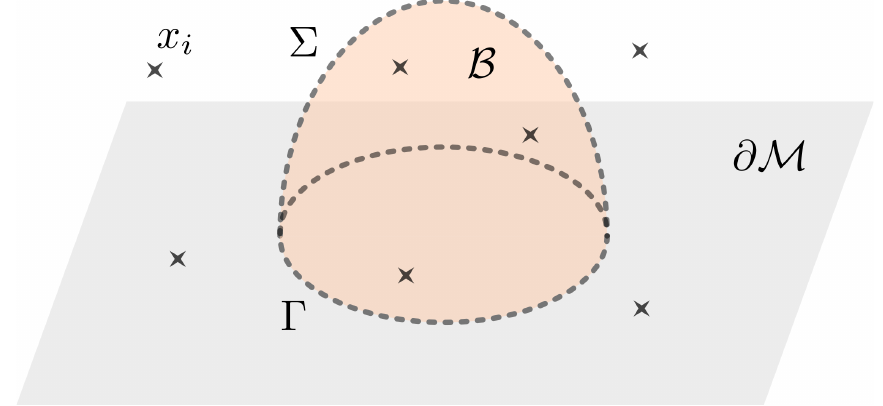
Figure 2 . Typical situation with a boundary. The boundary is represented by the opaque plane. Field insertions in the bulk and boundary are given by stars. The coloured domain is B . The dashed lines correspond to the boundary of B . In the bulk, this is the surface Σ , and on the boundary Γ = ∂ Σ . I is inserted all along the boundary of B Σ